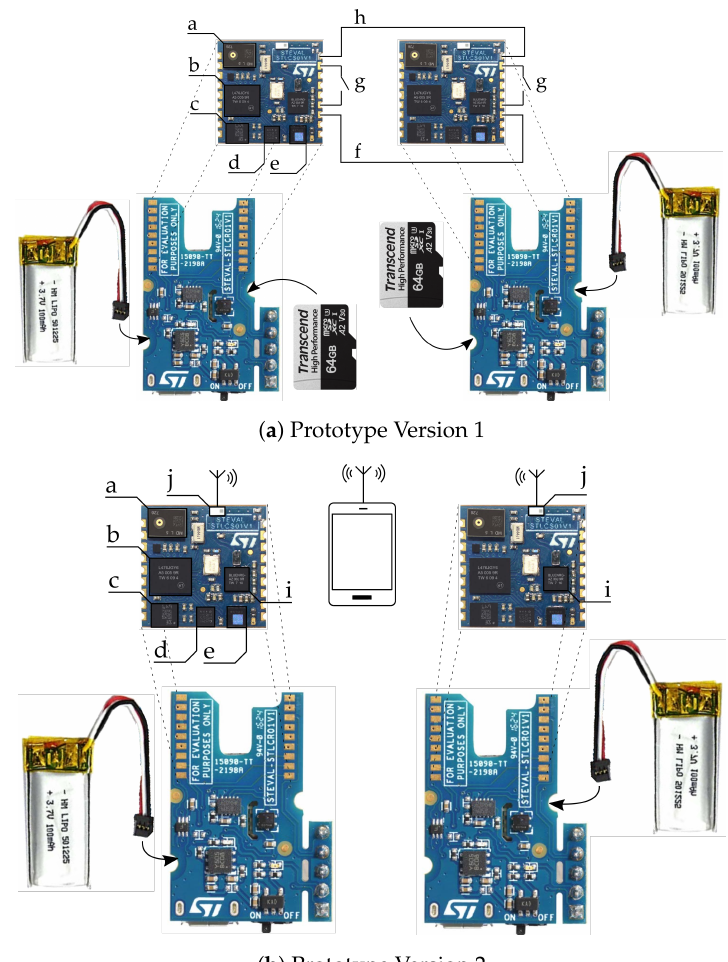
Figure 2. Two prototypes were developed for the experiment. The components on the printed circuit board (PCB) are indexed as follows with a: microphone, b: microcontroller, c: accelerometer and gyroscope, d: magnetometer, e: pressure sensor. ( a ) shows the first version of the wearable, with a wired synchronization and data labeling setup as the components are indexed with f: synchronization wire, g: labeling button, h: common ground. ( b ) shows the setup with a wireless synchronization via Bluetooth low energy (BLE) with the components indexed as i: BLE Communication chip and j: Antenna. The labeling of the data is done in an application running on the mobile